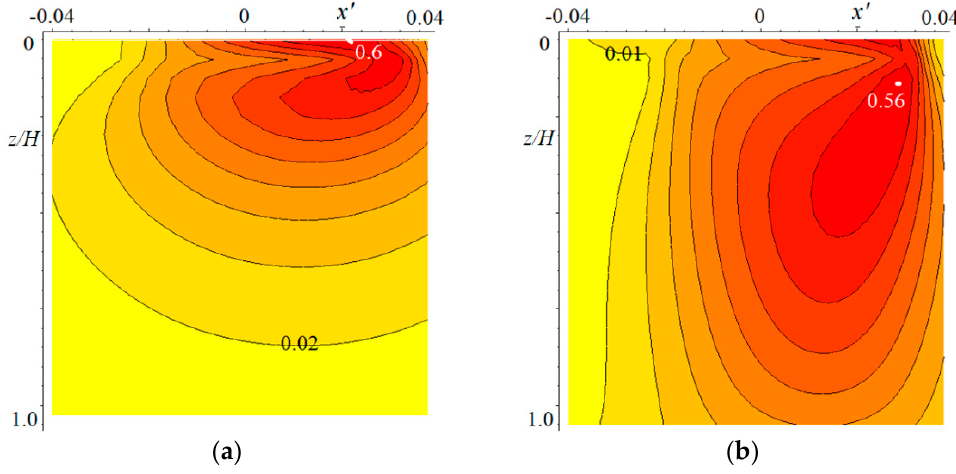
Figure 4. Distribution of the reduced stress: c = 5, ν = 0.4, p n (cid:48) = 4.2 · 10 − 2 , V (cid:48) = 0.0208, h (cid:48) = 0.1 ( a ) or h (cid:48) = 0.33 ( b